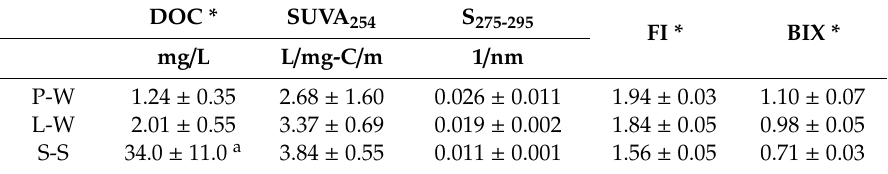
Table 2. Disolved organic matter (DOC) concentration and optical indices of P-W, L-W and S-S solutions. DOC * SUVA 254 S